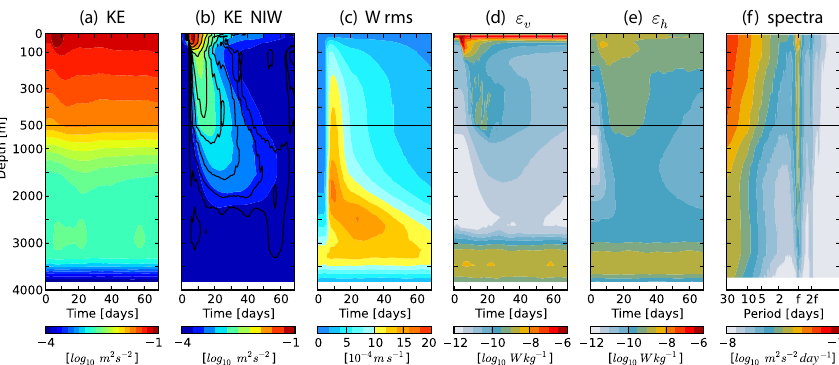
Figure 8. Response of the ocean to the passage of a single storm: (a) horizontal kinetic energy (log 10 m 2 s − 2 ) , (b) horizontal kinetic energy in the NIW band (colors, log 10 m 2 s − 2 ) and difference of horizontal kinetic energy between the simulation with storms and a reference simulation without storms (iso-contours), (c) rms of the vertical velocity (10 − 4 ms − 1 ) defined as average operator, (d) ε v energy dissipation due to vertical diffusion (Wkg − 1 ) and (e) ε h the energy dissipation due to horizontal diffusion (Wkg − 1 ) . These diagnostics are spatially averaged between L y / 3 and 2 L y / 3. The spatially averaged power spectra of the meridional velocity (log 10 m 2 s − 2 day − 1 ) is shown in (f) and has been computed using hourly data from day 0 to day 70. The storm starts at day 3 and ends at day